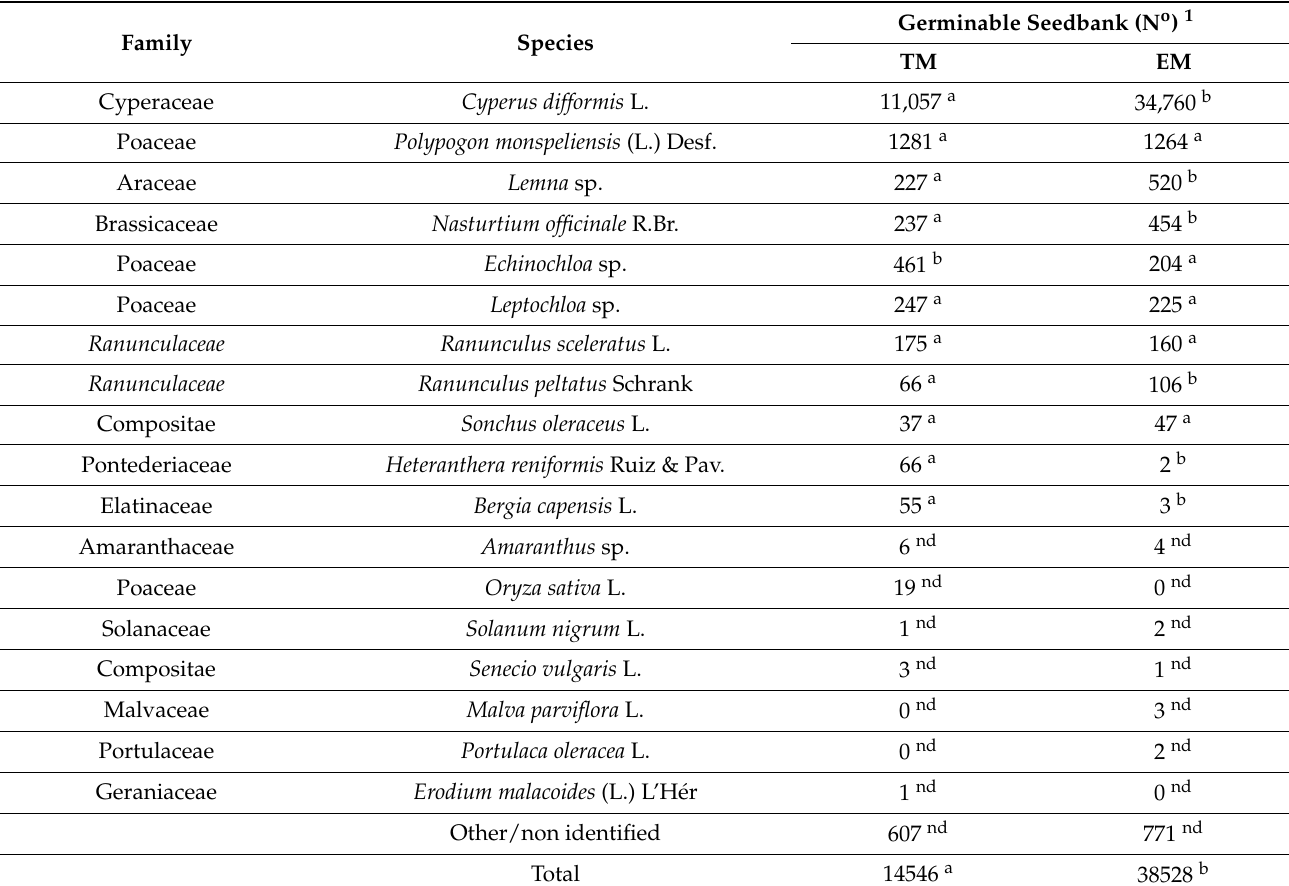
Table 3. Families, species, and number of viable seeds obtained by two estimation methods, try method (TM) and extraction method (EM), in the Valencia rice